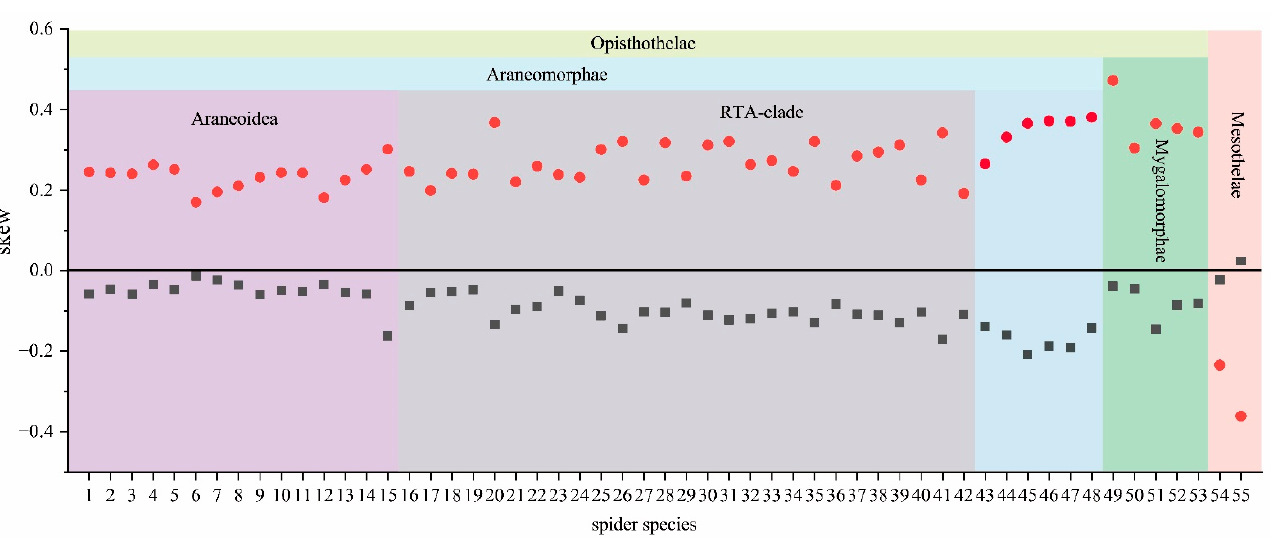
Figure 3. The AT-skew (grey squares) and GC-skew (red circles) of 55 species of the Araneae. The species names are as follows: 1. Araneus angulatus 2. Araneus ventricosus 3. Argiope amoena 4. Argiope bruennichi 5. Argiope perforata 6. Cyclosa argenteoalba 7. Cyclosa japonica 8. Cyrtarachne nagasakiensis 9.